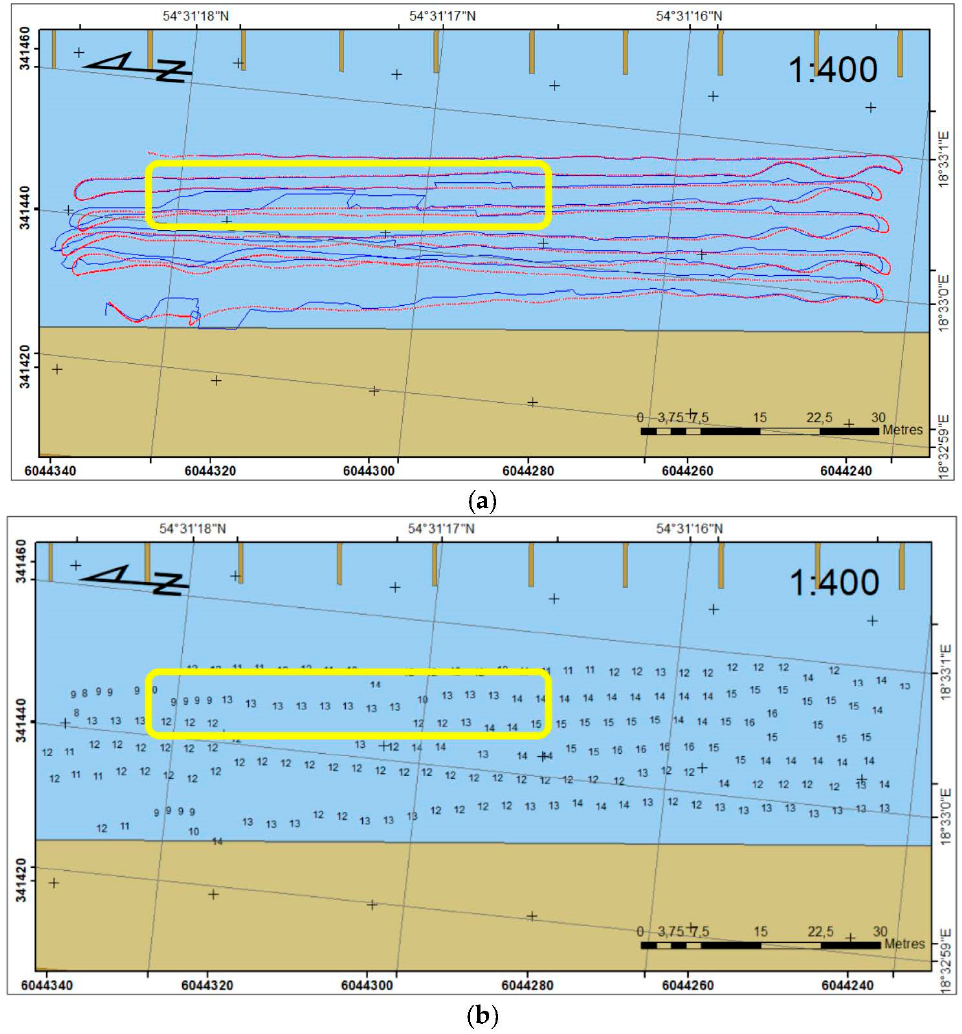
Figure 6. USV trajectory ( a ), total number of used satellites ( b ) for USV positioning (GPS +